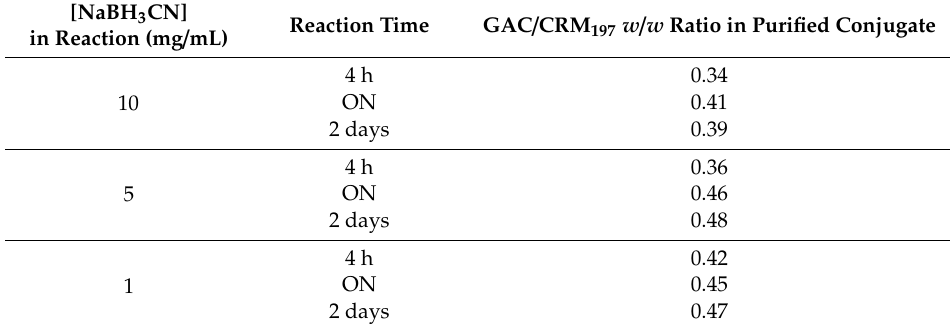
Table 3. Investigating role of NaBH 3 CN concentration and reaction time on GACox conjugation to CRM 197 .